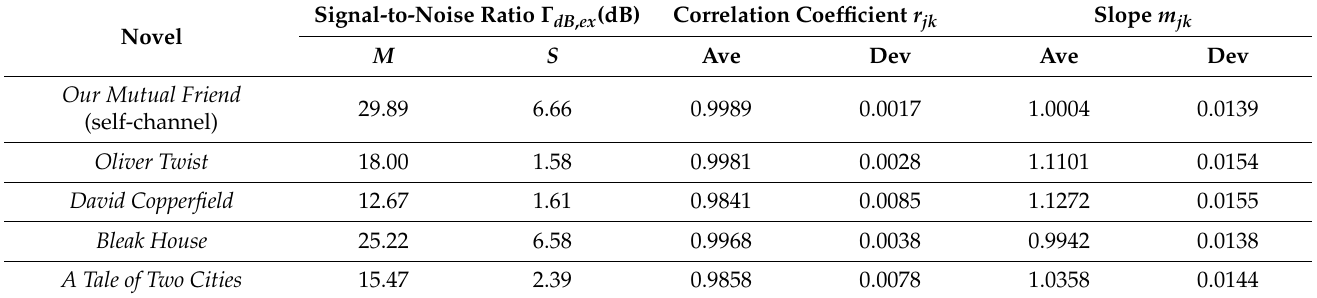
Table 9. Average value M (dB) and standard deviation S (dB) of Γ dB , ex (dB) in self- and cross-channels, correlation coefficient r jk , and slope m jk of the regression line between the number of sentences n S of Our Mutual Friend (channel output, self-channel) versus the number of sentences n S in the other Dickens novels (channel input, cross-channels), for equal number of words, in the sentences channel.